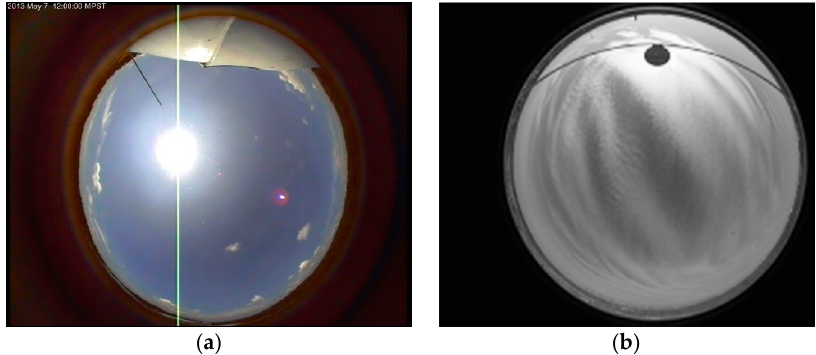
Figure 6. ( a ) An all-sky image taken from PERMATApintar Observatory during a clear sky with a blooming effect. ( b ) An example of solar obscuration that blocks the Sun (Radu et al. 2012) [10].